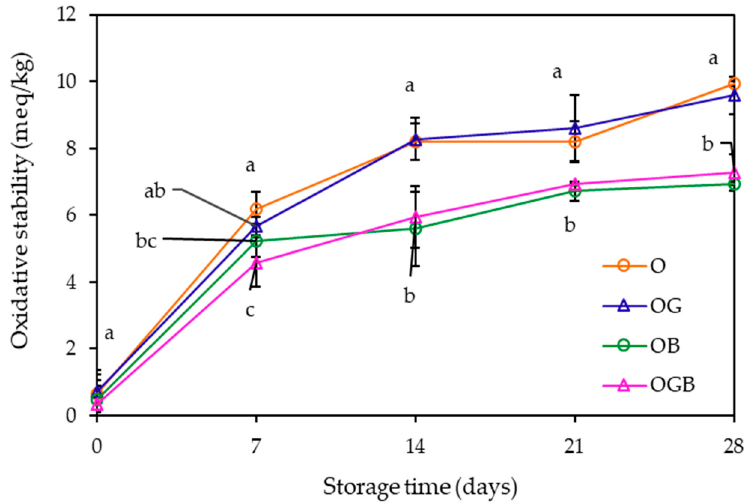
Figure 4. Oxidative stabilities of oleogels during storage (Means with different letters above the symbols differ significantly at p < 0.05, O: oleogel, OG: oleogel + GMS, OB: oleogel + β -carotene, OGB: oleogel + GMS + β -carotene).